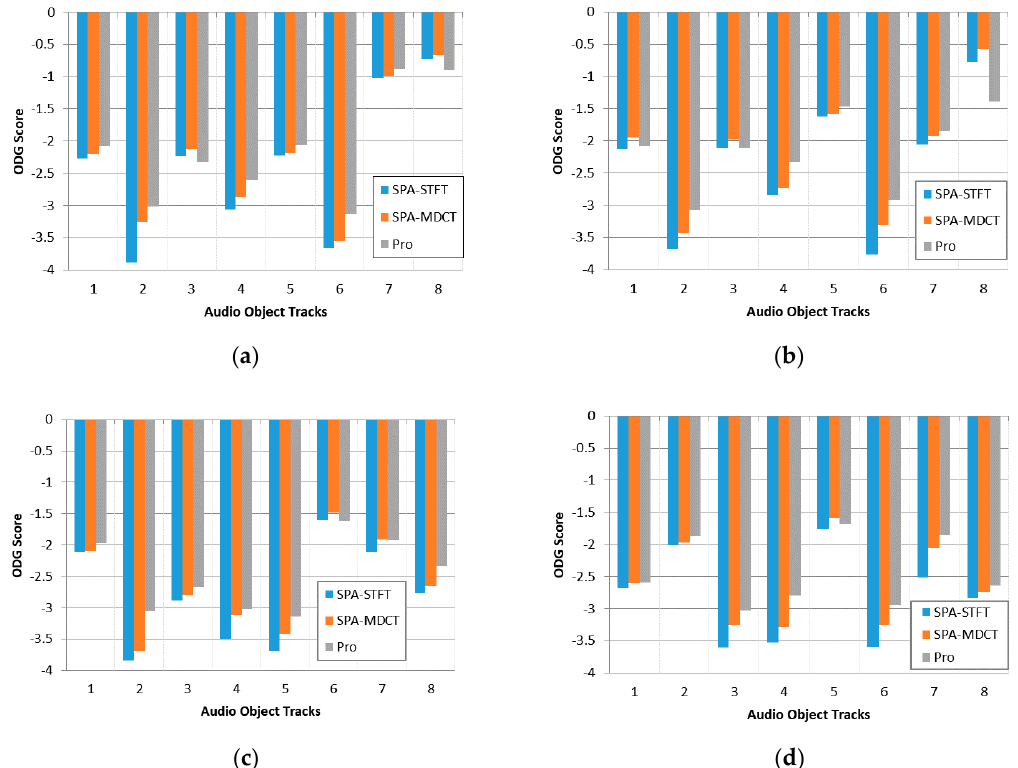
Figure 3. ODG (Objective Difference Grade) Score for the proposed audio object encoding approach and the SPA (Sparsity Analysis) framework (both in the STFT (Short Time Fourier Transform) and MDCT domain). ( a – d ) represent the results for 4 multi-track audio files.